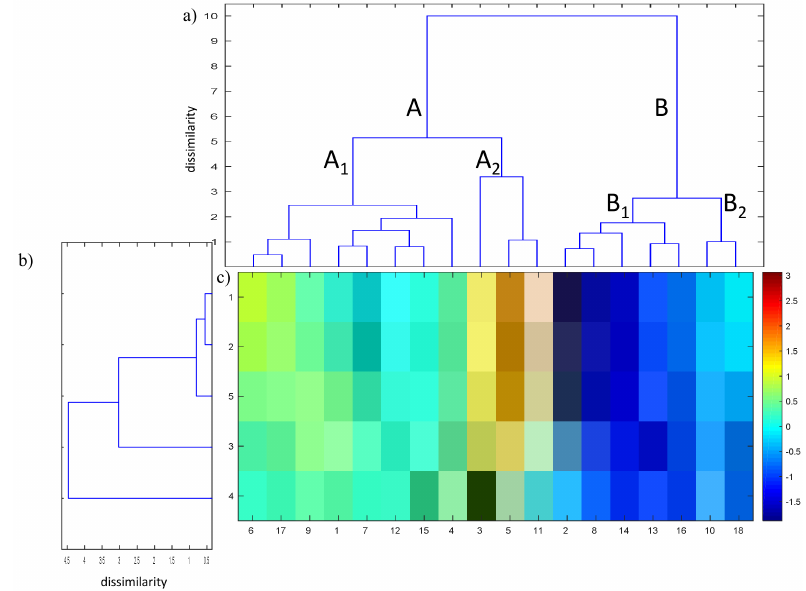
Figure 2. Dendrograms of: ( a ) studied biomass samples (objects listed in Table 2) in the space of measured parameters; and ( b ) parameters in the objects space; and ( c ) the color map of the studied data sorted according to the Ward linkage